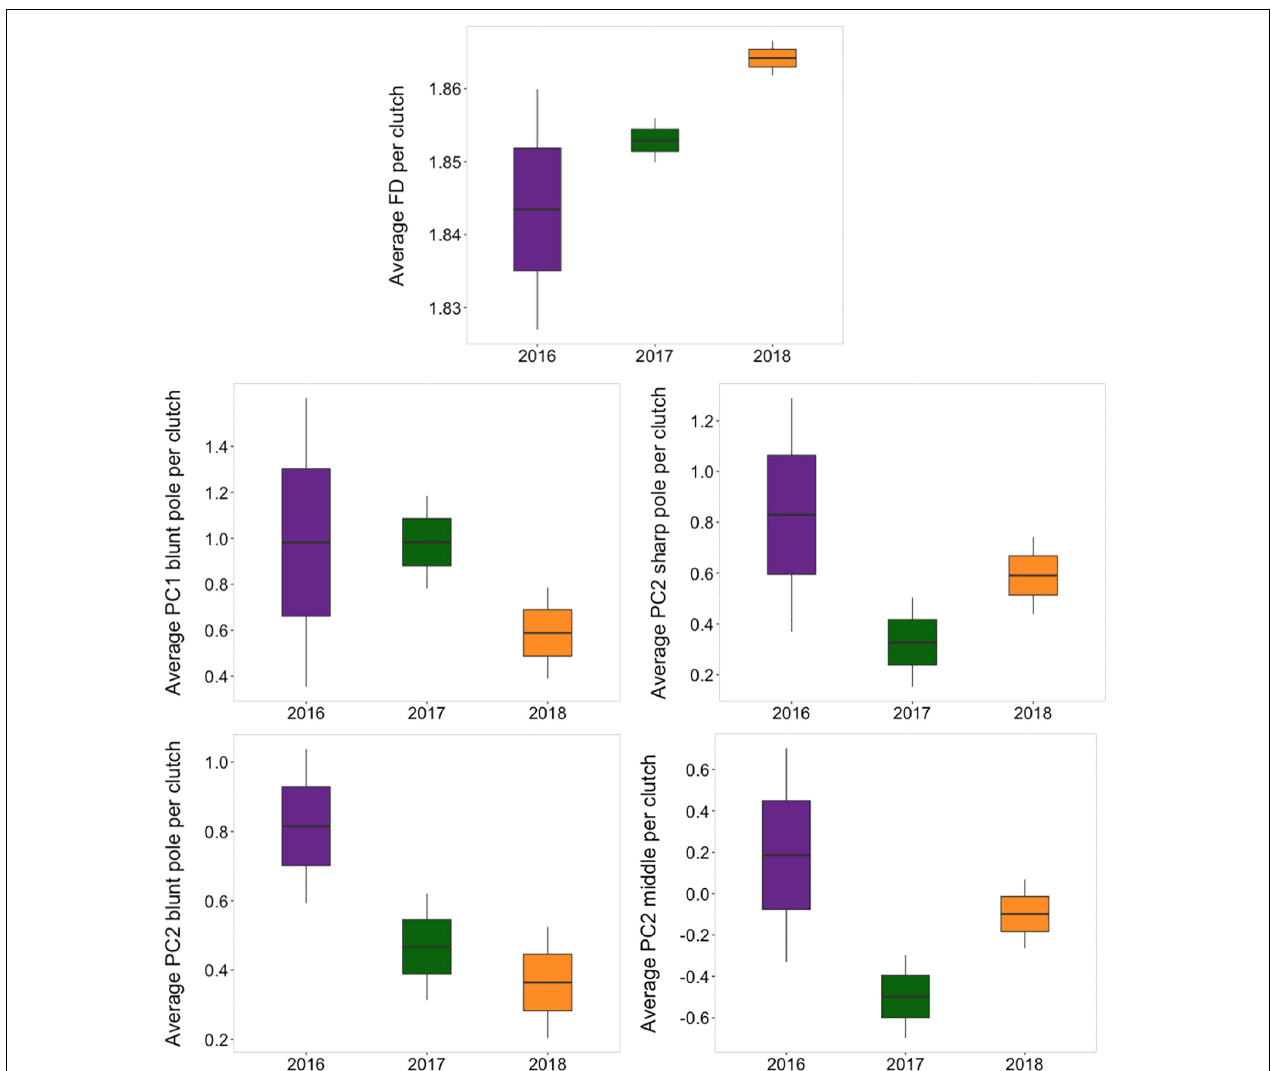
( Supplementary Table 2 ), the average phenotype of magpie eggs in the population changed ( Supplementary Table 3 ). Specifically,